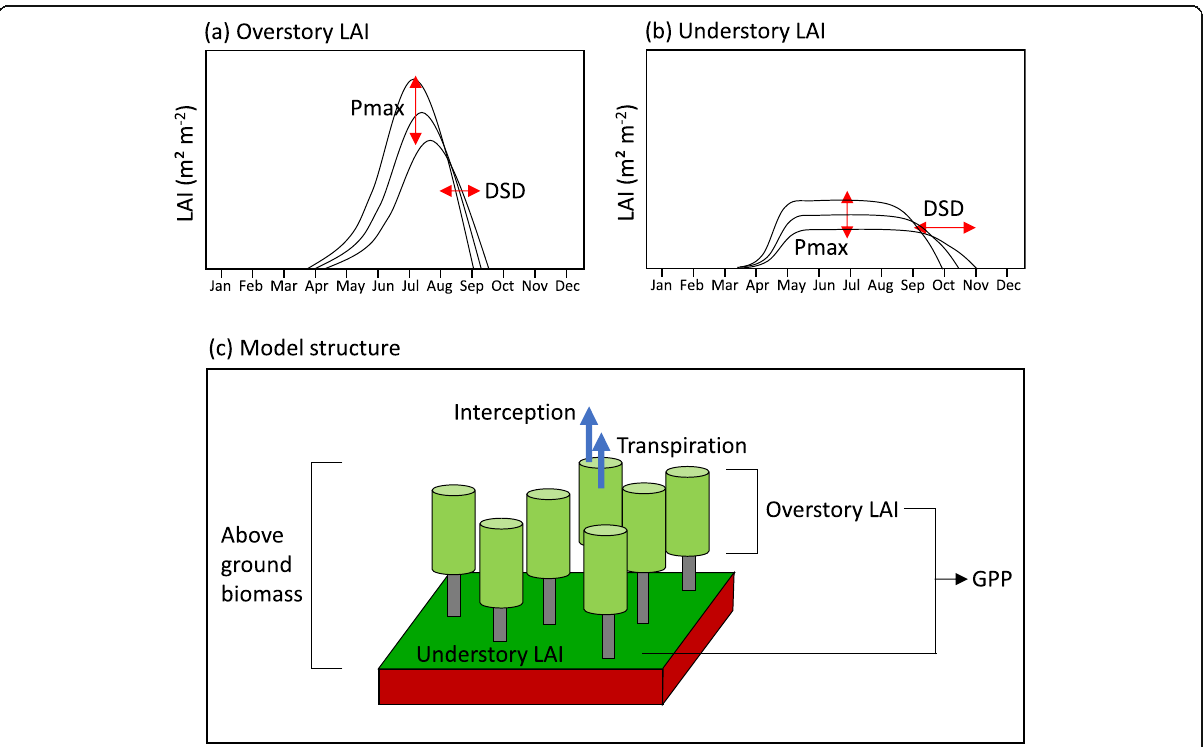
Fig. 2 The schematic diagram for a Pmax, b DSD, and c model